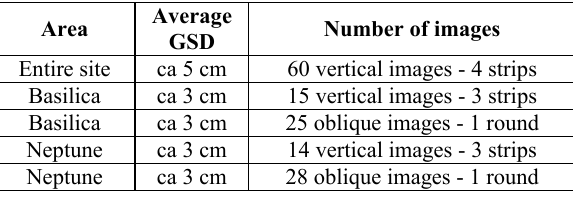
Table 1. UAV surveying of the archaeological monuments and site - collected images and average ground resolution.